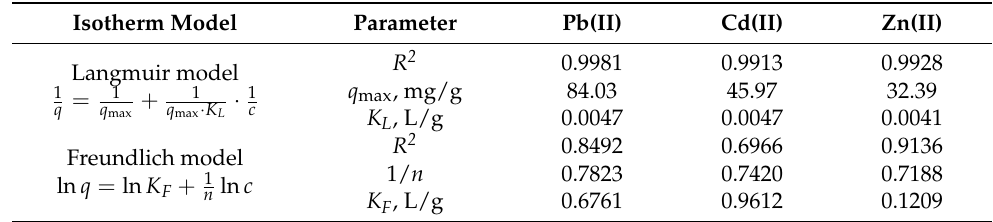
Table 2. Isotherm parameters obtained for the biosorption of studied metal ions on Na-SW biosorbent. Isotherm Model